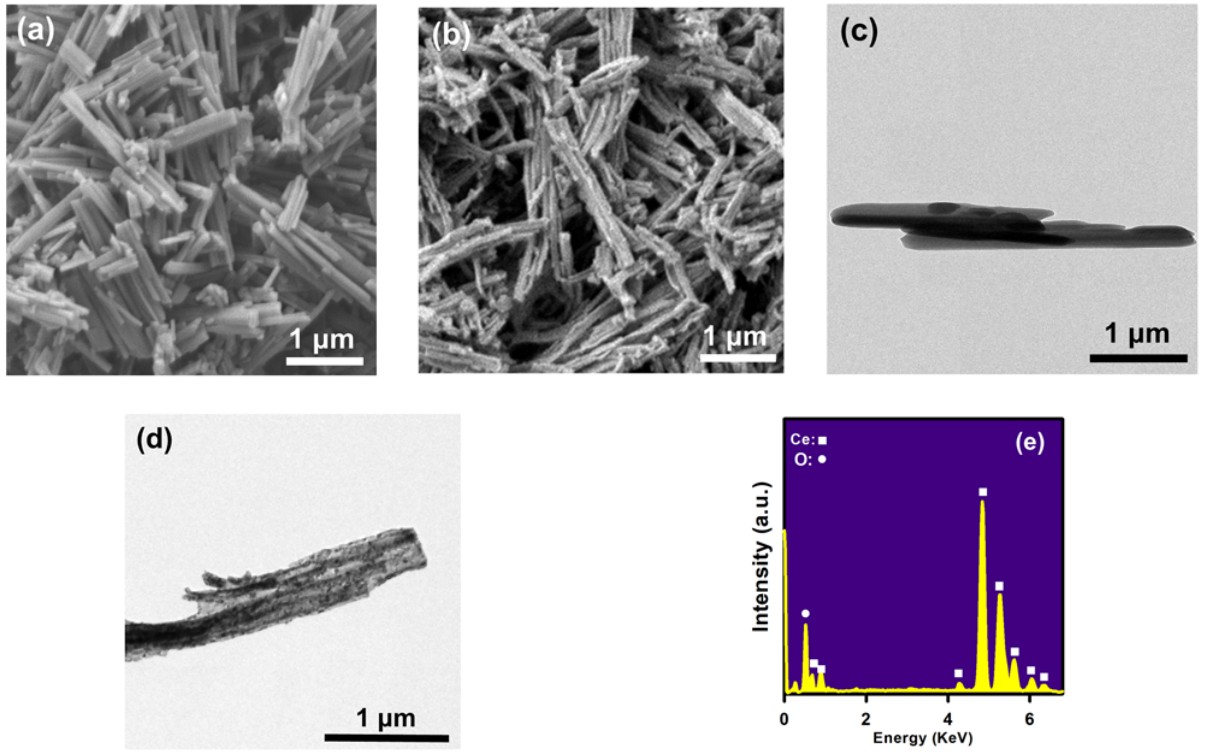
Figure 2. ( a ) SEM image of bar-like Ce-MOF, ( b ) SEM image of CeO 2 nanobar (CeONB)-derived from Ce-MOF, ( c ) TEM image of Ce-MOF, and ( d ) CeONB; ( e ) EDS analysis.